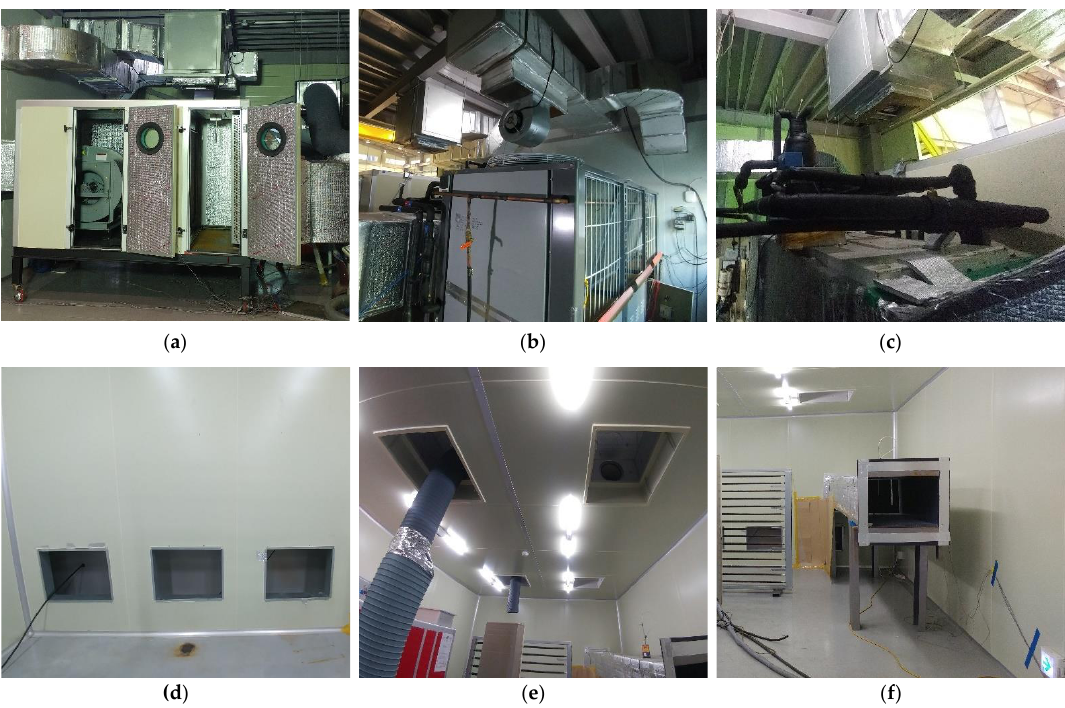
Figure 8. ( a ) Air conditioner; ( b ) Ceiling duct of the outdoor unit; ( c ) Refrigerant pipe of the vapor– liquid separator; ( d ) Indoor return chamber inlet; ( e ) Indoor air supply and exhaust duct; ( f ) Indoor air supply duct.